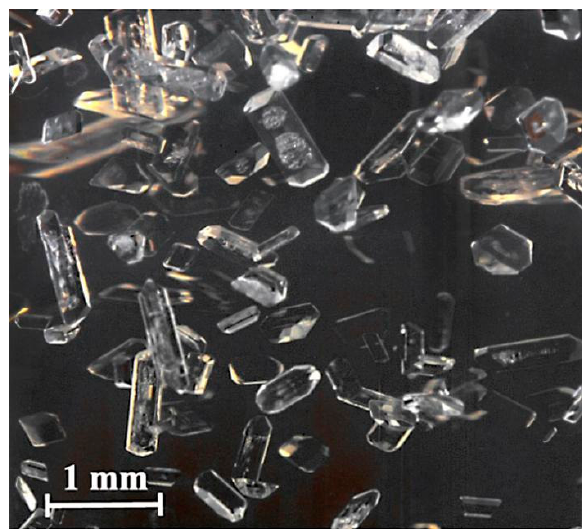
Figure 1. Struvite crystals in sodium metasilicate gel.